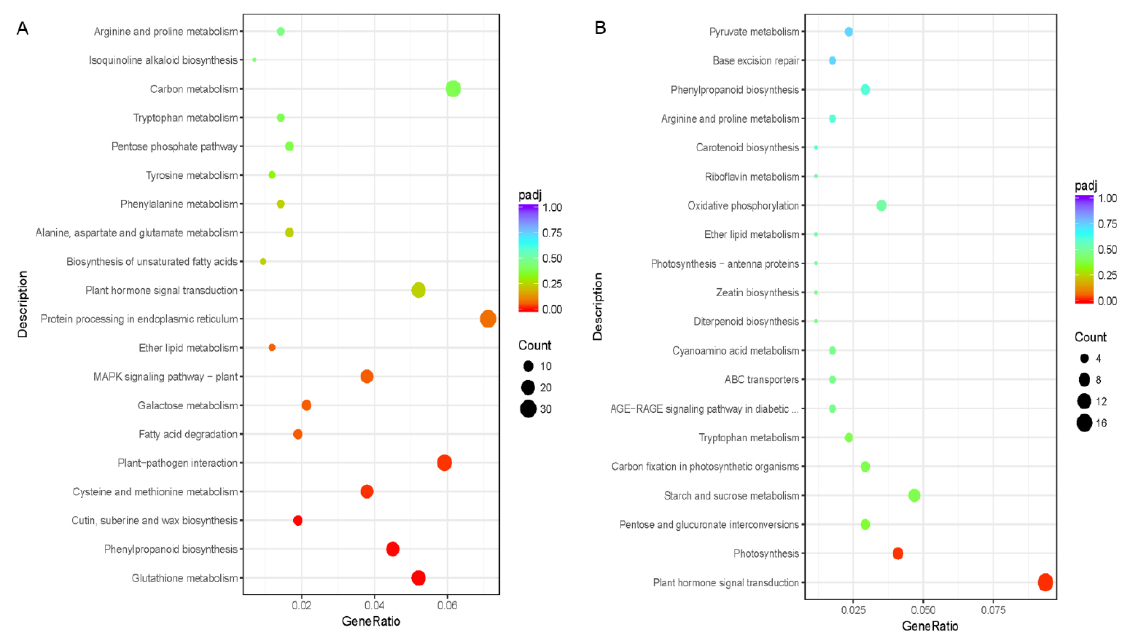
Figure 2. Kyoto Encyclopedia of Genes and Genomes (KEGG) pathway enrichment analysis of the up- ( A ) and downregulated ( B ) DEGs in the comparison of trichomes vs. leaves. The top 20 statistically significantly enriched KEGG pathways for each treatment are shown.